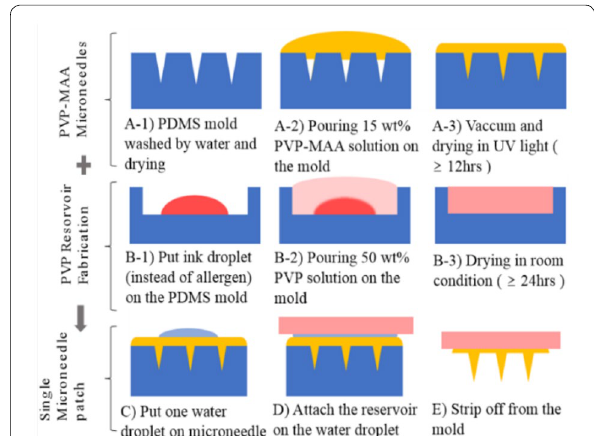
Fig. 2 Fabrication of the polymeric microneedle with drug reservoir